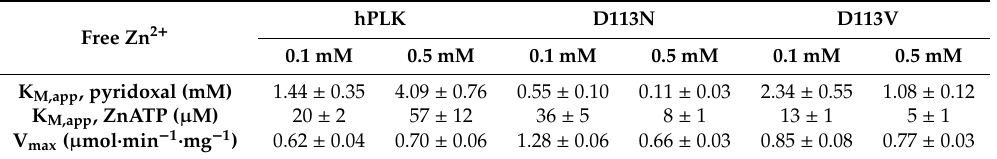
Table 3. Kinetic parameters for wild type hPLK and D113N and D113V